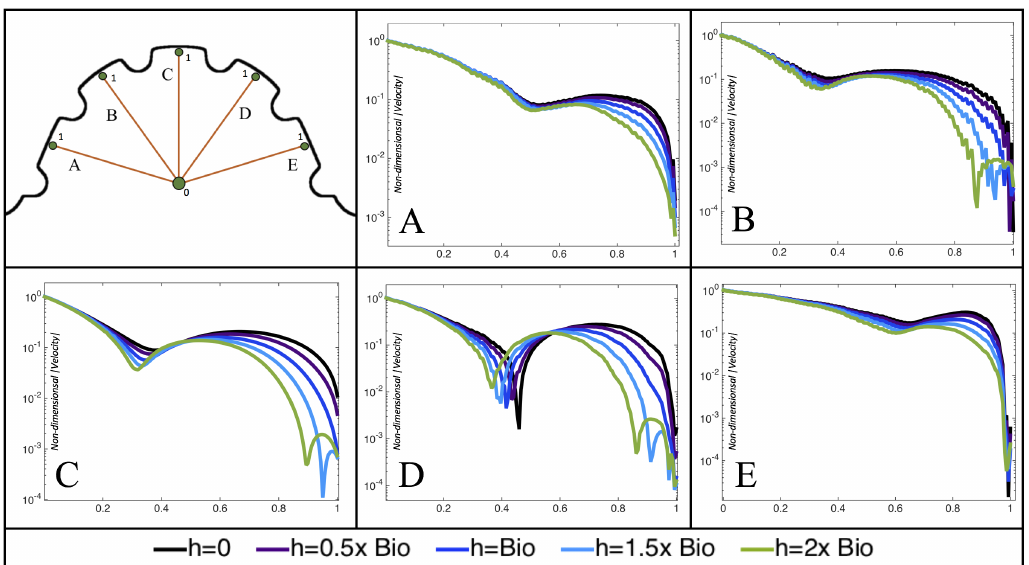
Figure 18. Measurements of the non-dimensional magnitude of velocity are provided for the Re = 100 case quantified along a line from the intracardial center (labeled “0”) and extending to the ventricular lining (labeled “1”) for various intertrabecular regions and trabeculae heights. Each subfigure ( A – E ), corresponds to a different line between the intracardial center and ventricular lining in which the magnitude of velocity is measured. The velocity magnitude decreases from the center and then increases before decreasing again as one approaches a distance from the wall that is equal to the neighboring trabeculae heights. As one moves between the trabeculae, the velocity magnitude again increases, in some cases an order of magnitude, before dropping towards zero at the ventricle